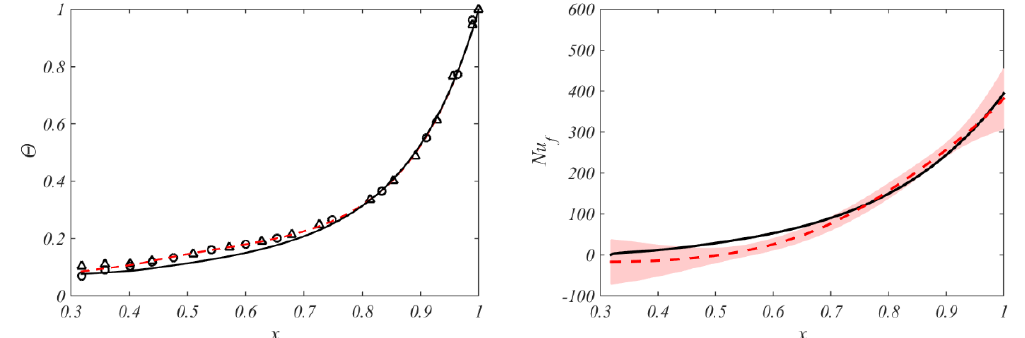
Figure 10. Distributions of nondimensional temperature and Nusselt numbers for Case a ( Ro ≈ 0.6, Gr f = 2.5 × 10 11 , Re ϕ = 1.6 × 10 6 , Re z = 5.1 × 10 4 ) Solid lines are theoretical curves; broken lines are results from Bayesian model, and shading shows uncertainty in Nu f ; symbols denote temperature [6].